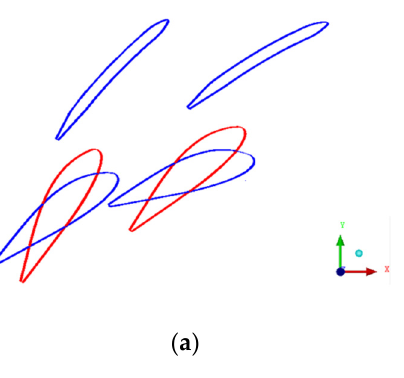
Figure 6. ( a ) Guide vane flow channel comparison. ( b ) Runner blade angle comparison. The green area represents the runner hub. Best efficiency point in red and SNL in blue.